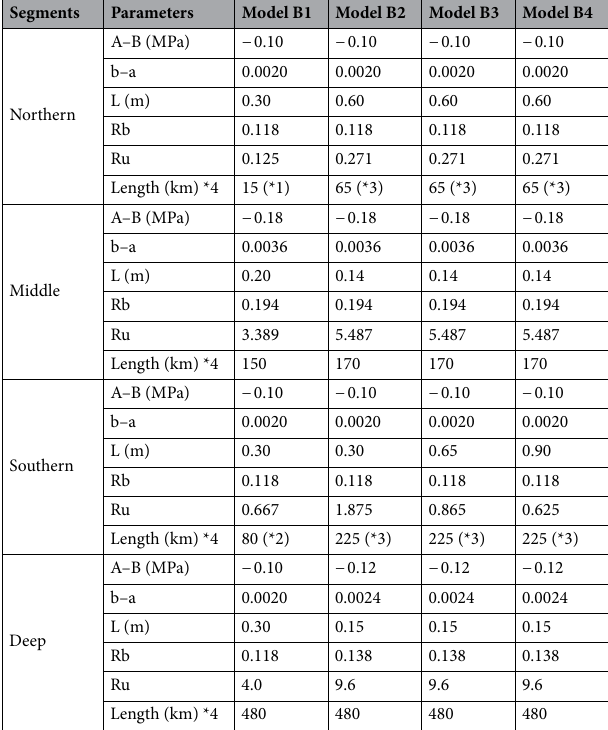
Table 1. Parameters at the northern, middle, southern, and deep segments for four models. *1: Transition between the middle and northern segments is 75 km. *2: Transition between the middle and southern segments is 160 km. *3: Transition between the middle segment and northern/southern segment is 10 km. *4: Length along strike